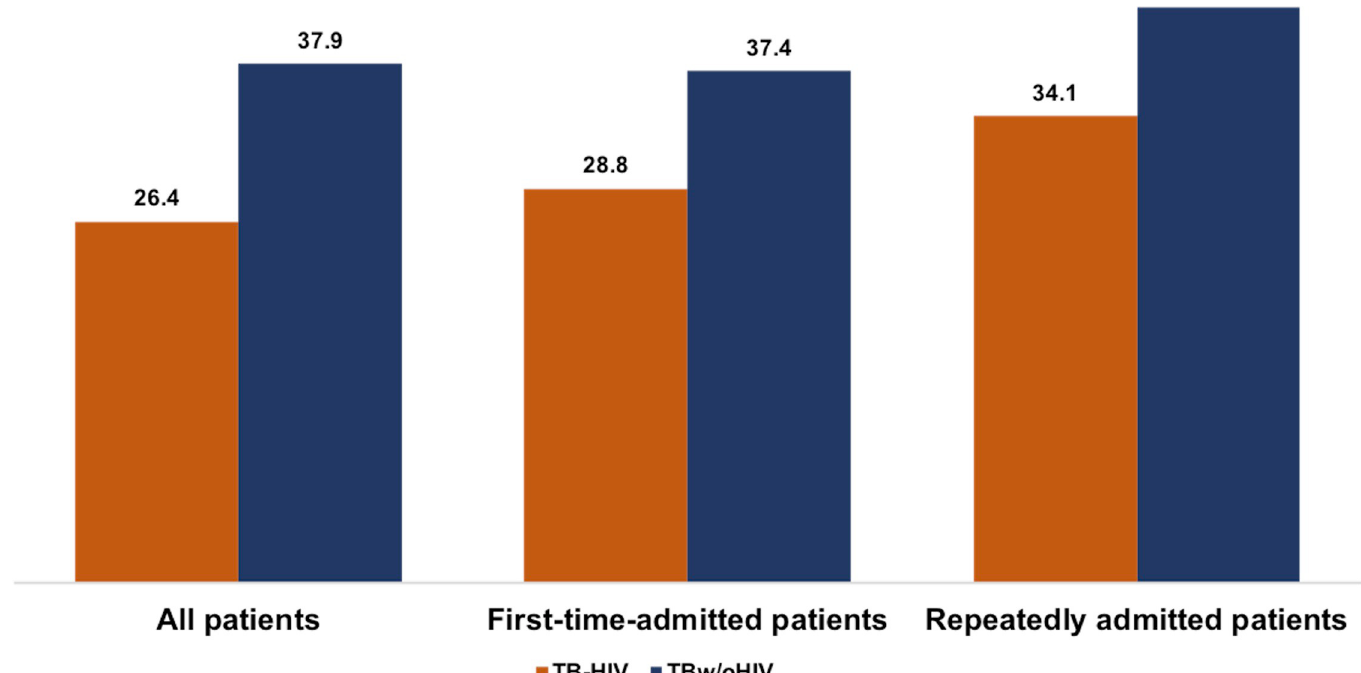
Fig 2. AFB smear positivity rates for the TB-HIV group and TBw/oHIV group.